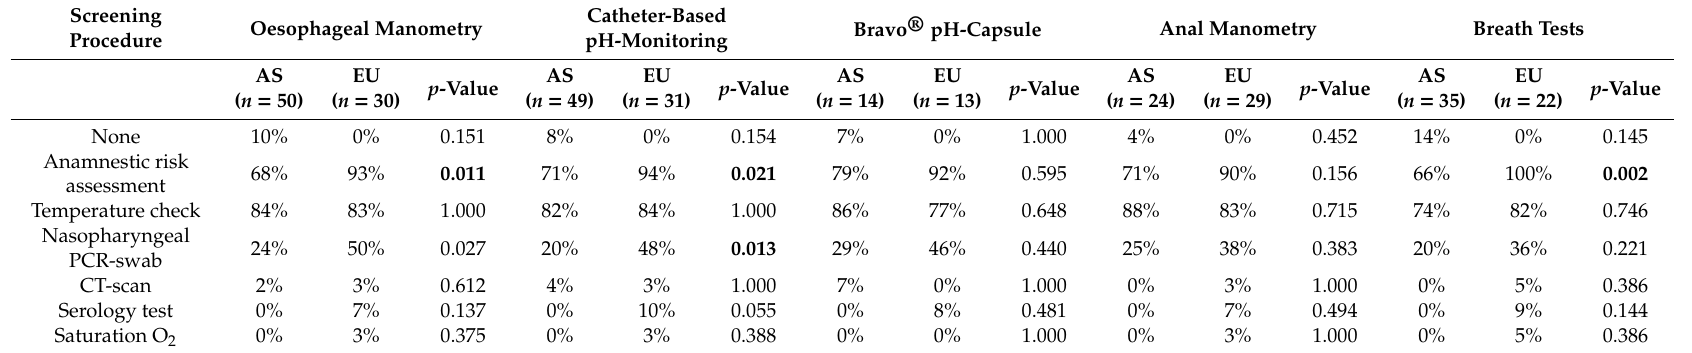
Table 2. Screening procedures used prior to performing gastrointestinal motility